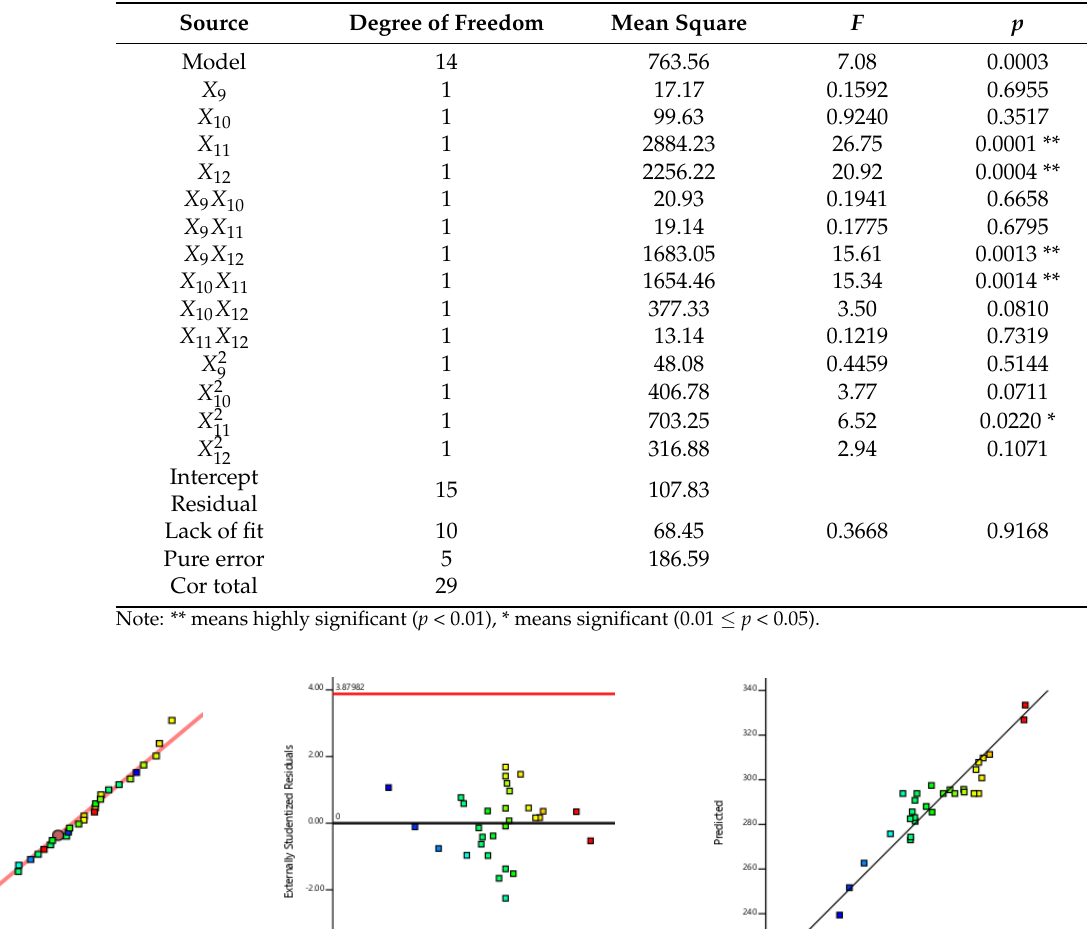
Table 11. Analysis of variance of the quadratic regression model for the response surface of the epidermis and flesh bending damage force.